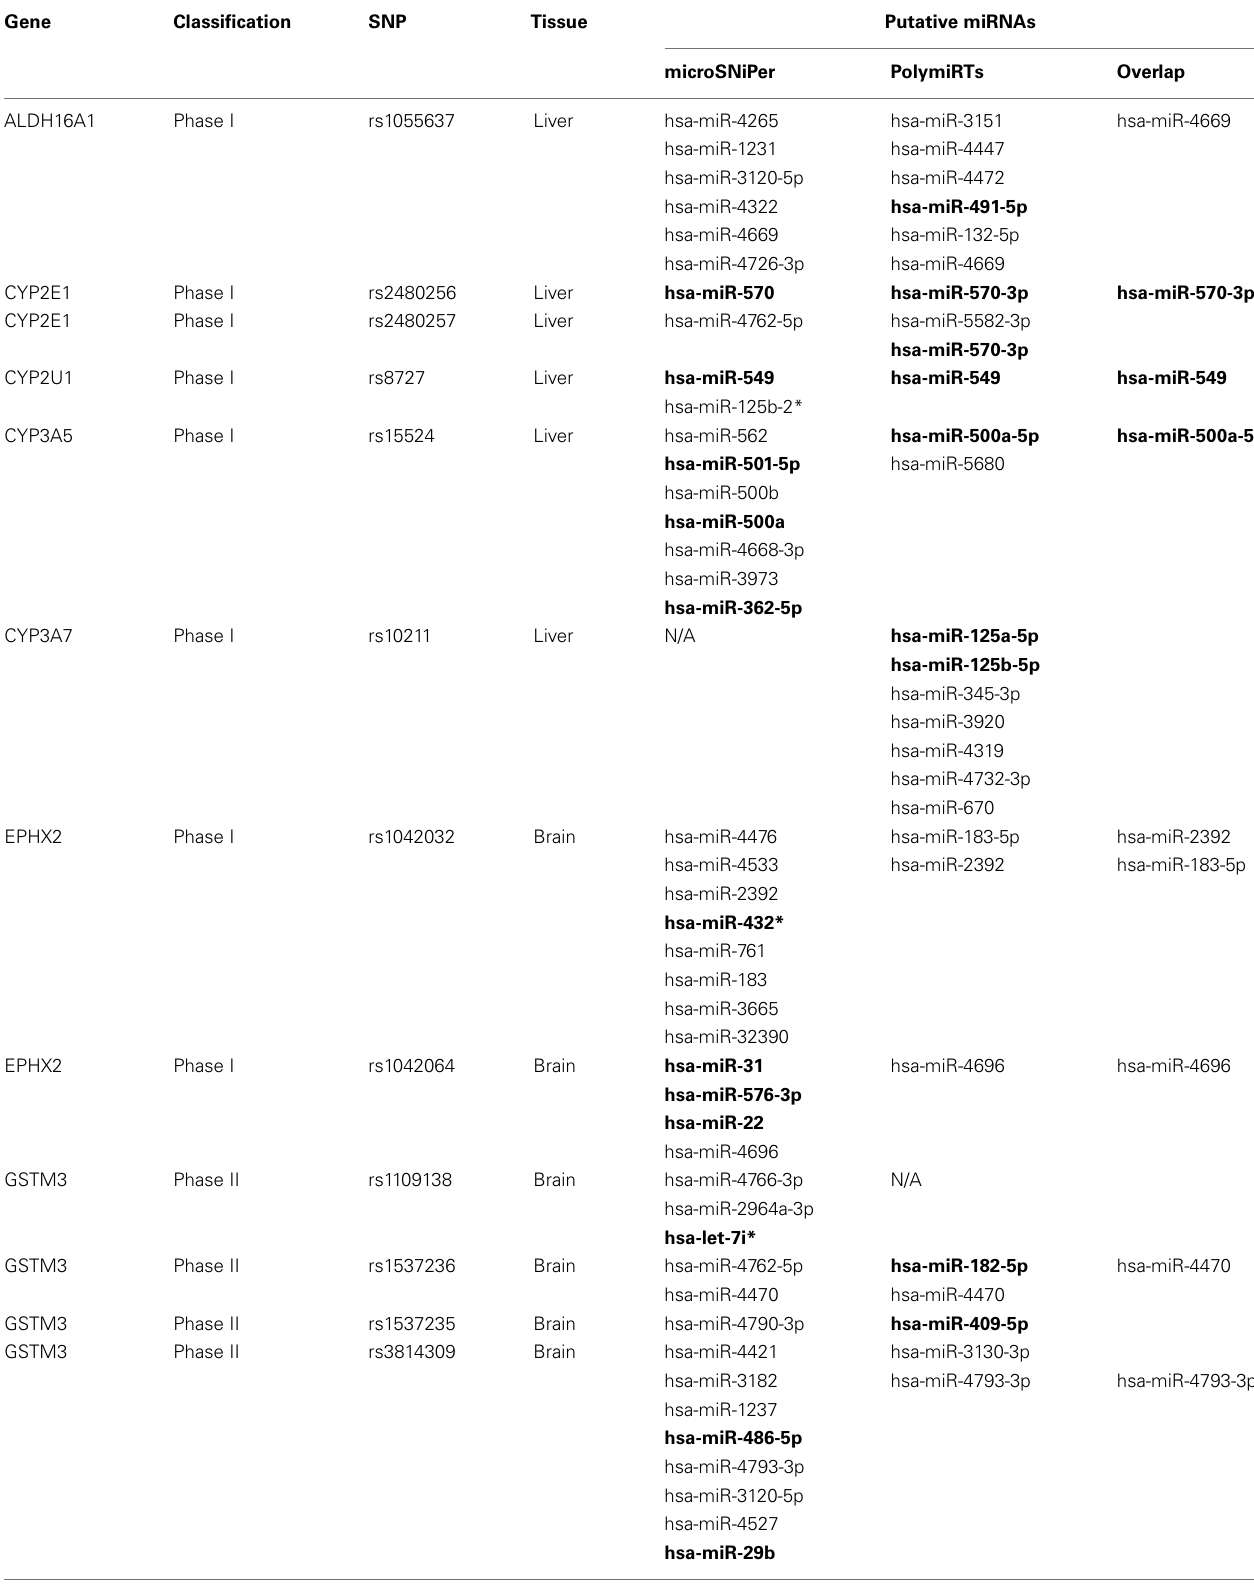
TableA2 | Putative miRNAs associated with SNPs in the 3 (cid:48) -UTR region. Gene Classification